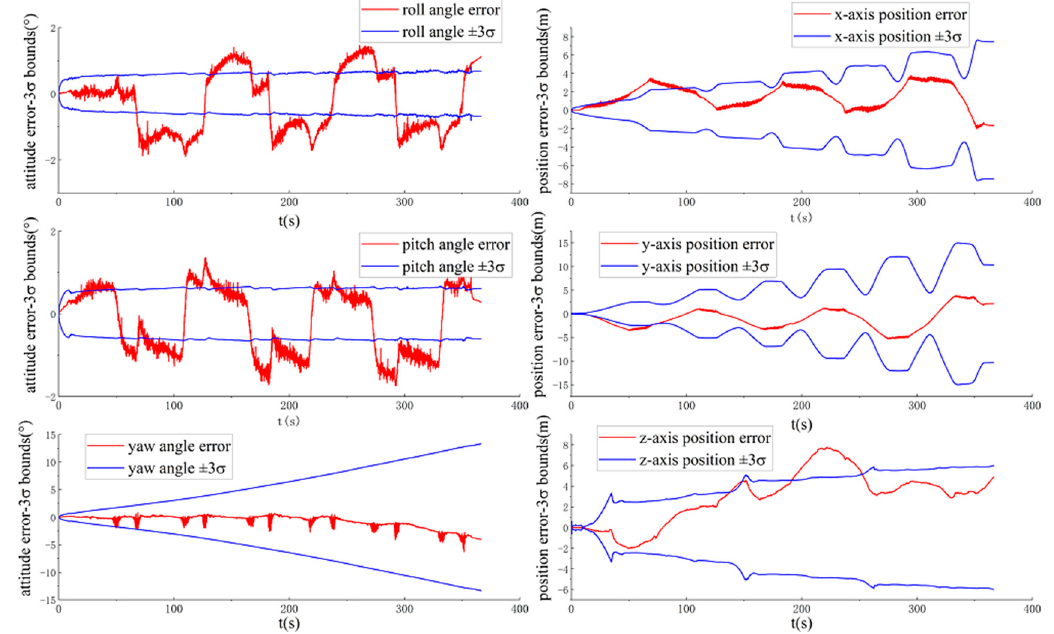
Figure 9. The ground-truth pose errors and estimated ± 3 σ bounds of MAVIO(2) with time for the VD06 dataset.